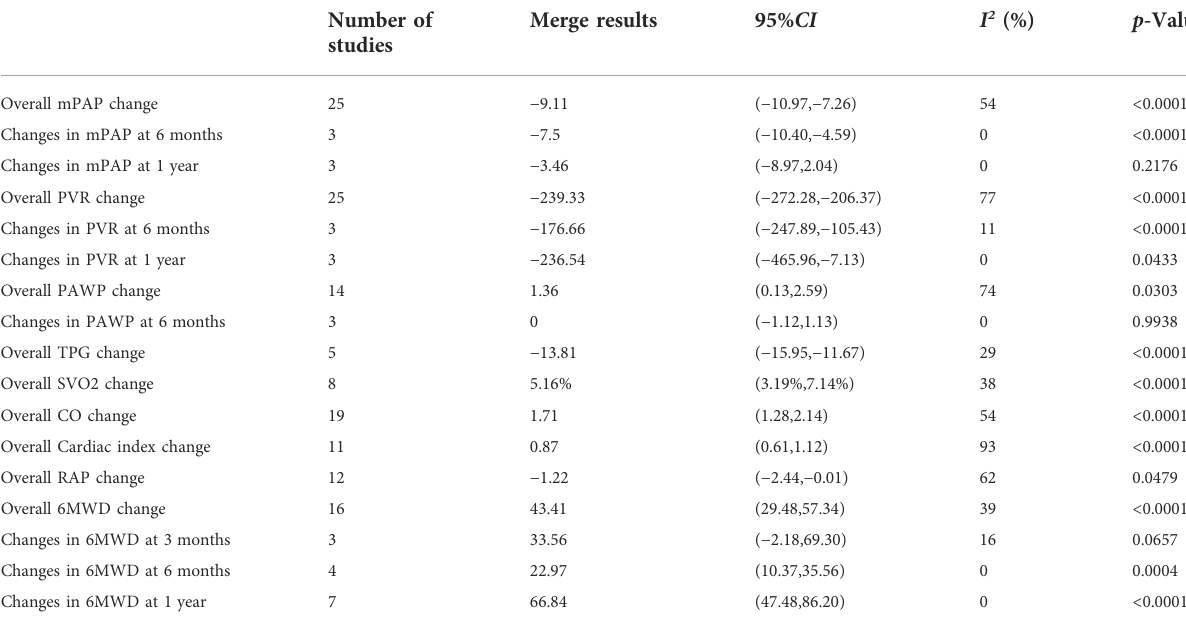
TABLE 3 Changes of hemodynamics and 6 MWD in all patients with POPH.